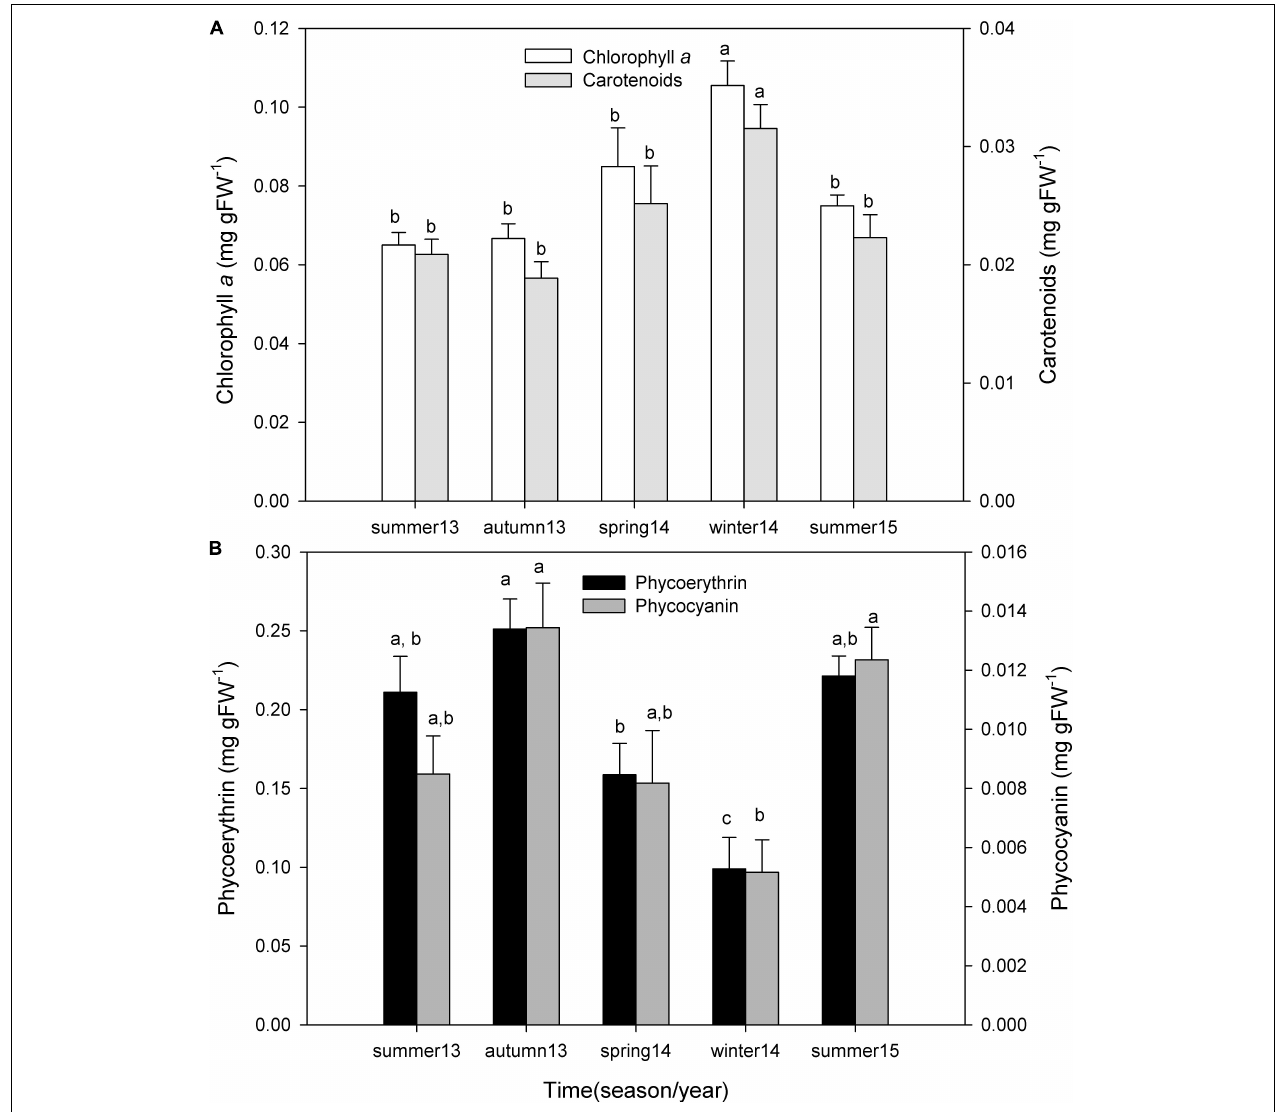
FIGURE 6 | Seasonal variation of chlorophyll a and carotenoid pigment concentration (A) , and phycoerythrin and phycocyanin pigment concentration (B) of P. lusitanicum (mg gFW − 1 ). Different letters indicate significant differences between seasons for each photosynthetic pigment. Mean values ± standard error ( n = 5).